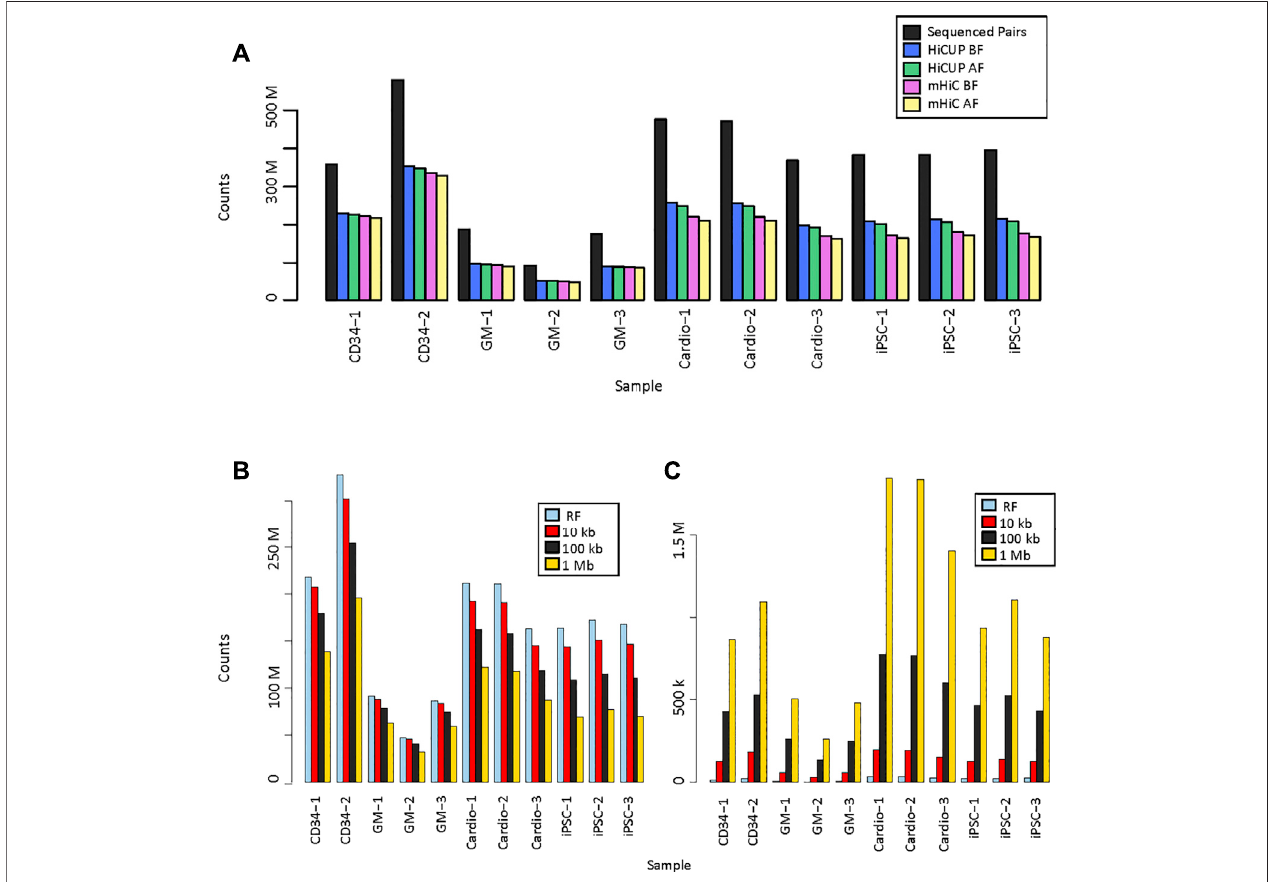
FIGURE 2 | Valid read pairs. (A) . Number of identi fi ed valid pairs using HiCUP and mHiC. Black bars indicate the total number of raw read pairs. Read pairs were fi ltered to keep only those with a mapping quality (MAPQ) ≥ 10. BF: number of mapped read pairs before MAPQ fi ltering. AF: number of mapped reads after MAPQ fi ltering. (B) . Number of uniquely mapping read pairs using mHiC at different resolutions. (C) . Number of rescued multi-mapping read pairs using mHiC at different resolutions. RF: restriction fragment.